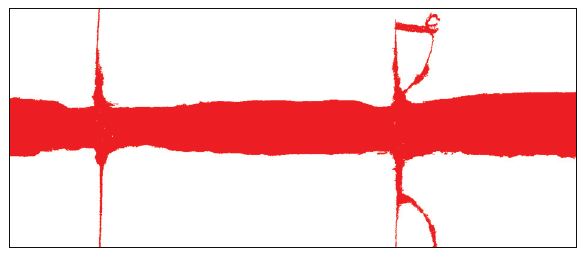
Figure 11: Principal binary